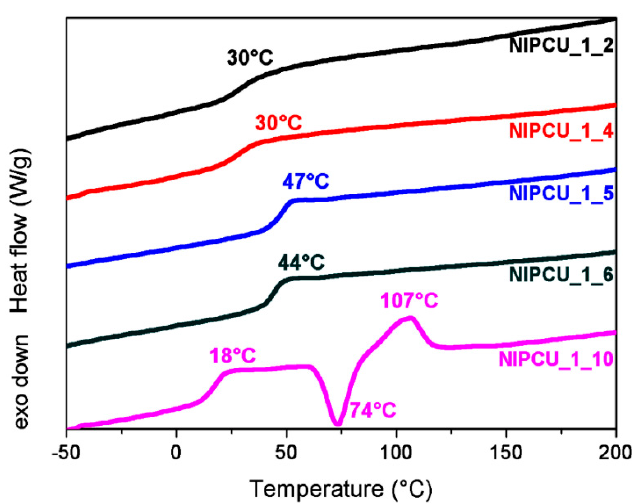
Figure 6. Thermal properties of the NIPCUs differing in their structures of hard segments.